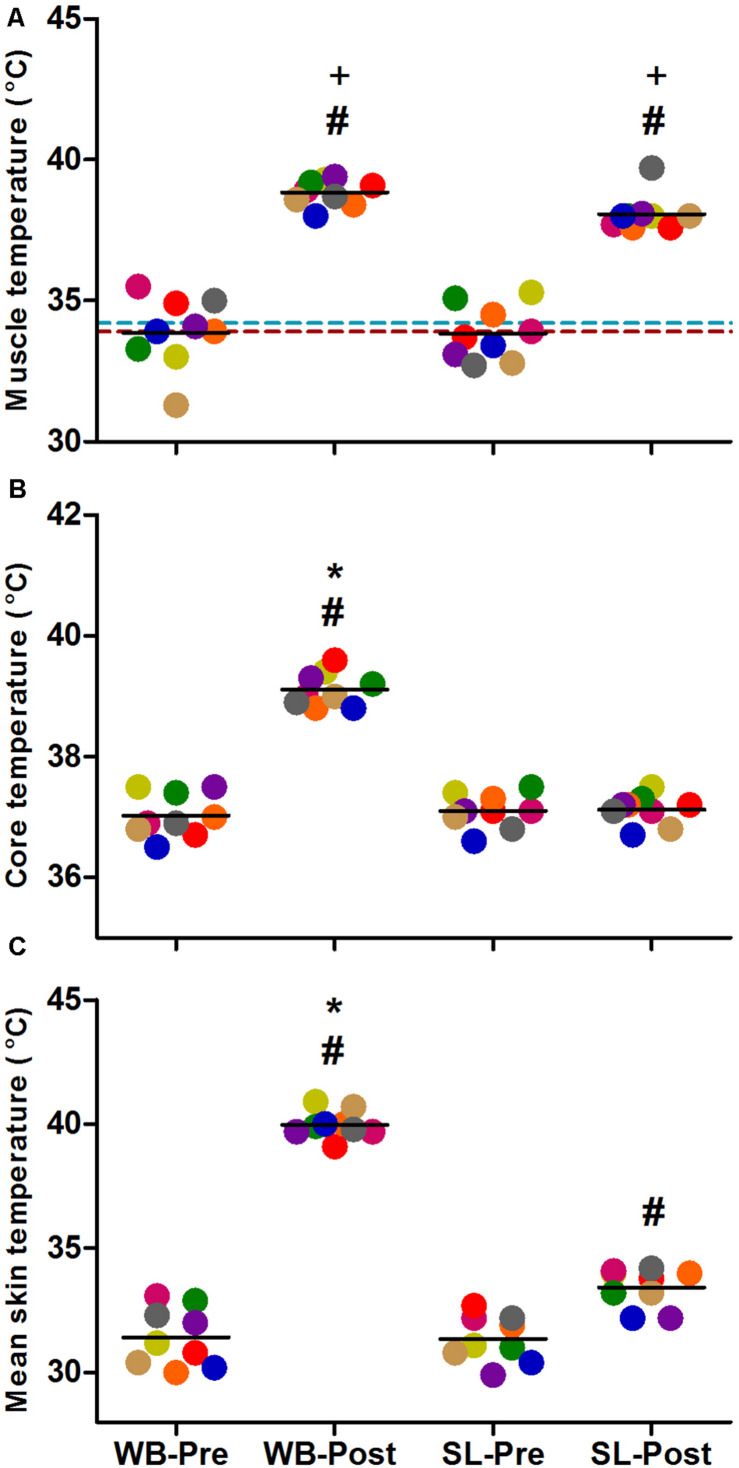
Changes in muscle temperature (A), core temperature (B) and mean skin temperature (C) during whole body (WB) heat stress and single-leg heat stress (SL). Broken blue and red lines indicate pre and post muscle temperatures, respectively in the CON leg during SL. #different compared with PRE within condition. *Different compared with SL at POST. +Different compared with CON leg during SL at POST.